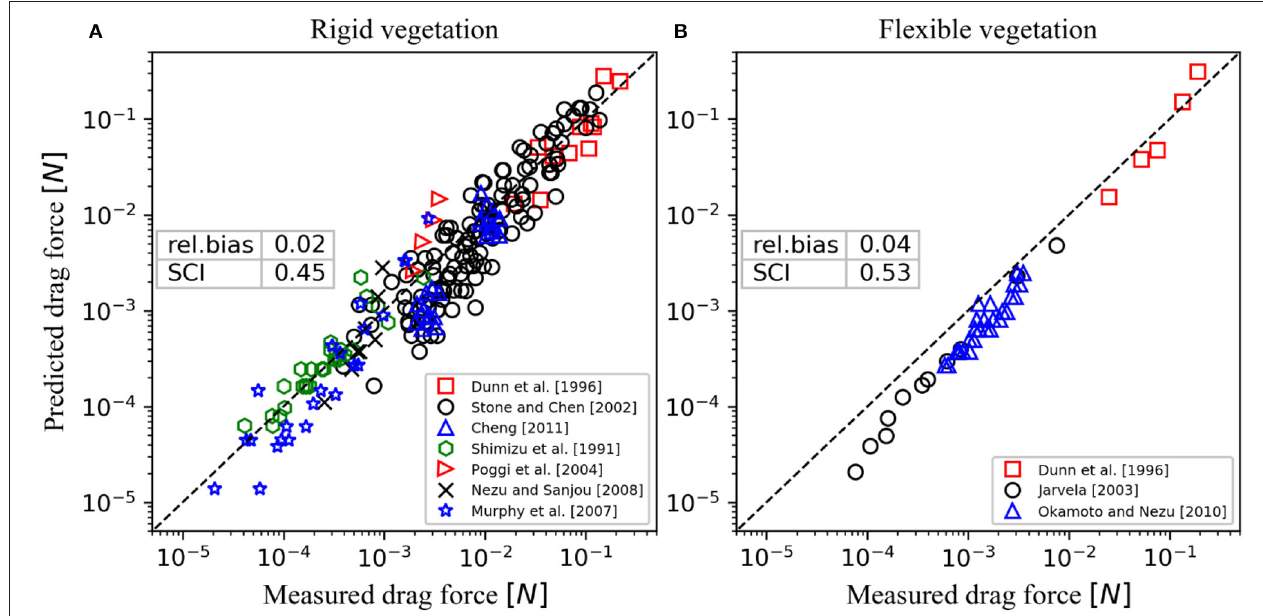
FIGURE 10 | Validation of canopy drag model for submerged canopies against previous experimental results with (A) rigid and (B) flexible vegetation (listed in Tables 3 , 4 , respectively).